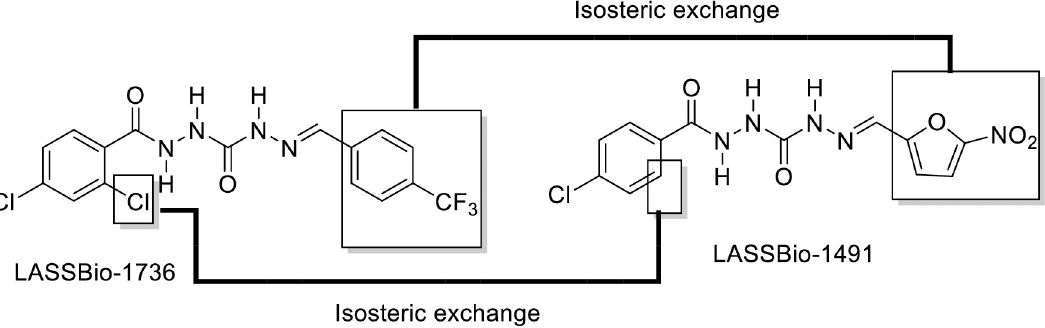
Fig 1. Chemical structure of LASSBio-1491, an isostere of LASSBio-1736 designed by isosteric replacement of monovalent groups (Cl x H; CF 3 x NO 2 ) and ring exchange (phenyl x